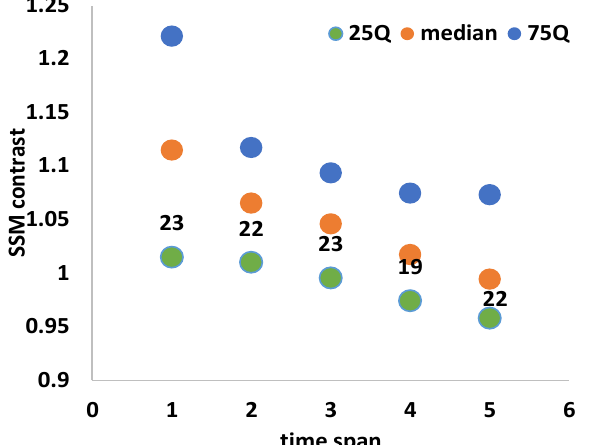
Figure 8. First quartile (25Q, green points), median (orange points) and third quartile (75Q, blue points) of the SSM contrast between irrigated and non-irrigated wheat/barley fields as a function of the time span ( TS ) between the irrigation events and the S-1 passages. The number of the S-1 acquisition dates is also reported.